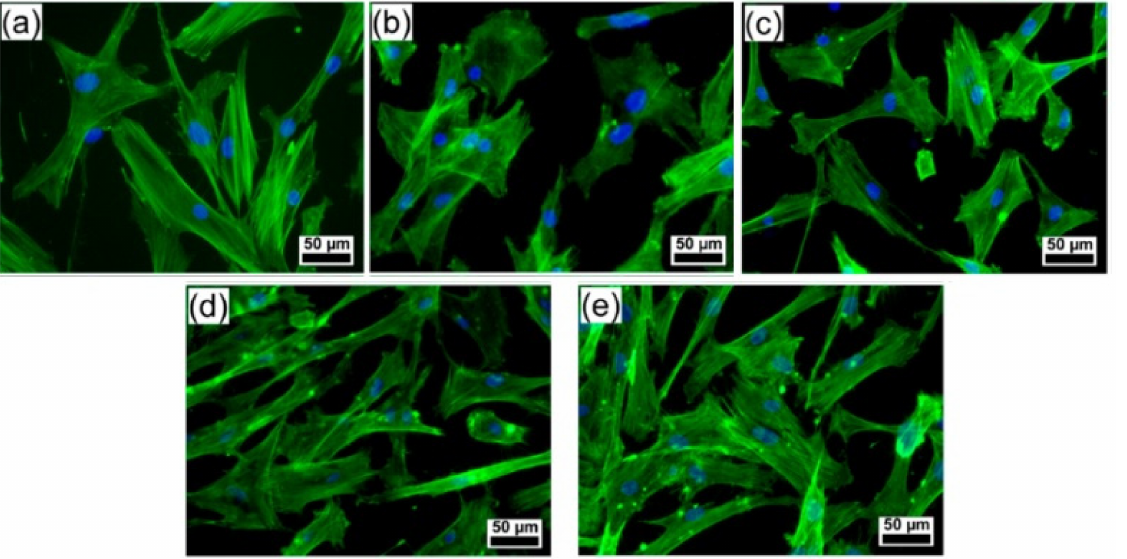
Figure 6. Fluorescence microscopy images of human gingival fibroblast cells morphology on the surface of ( a ) control (polystyrene surface ( b ) simple Ti, ( c ) commercial HA, ( d ) sea bream-BCP, and ( e ) salmon-BCP coatings